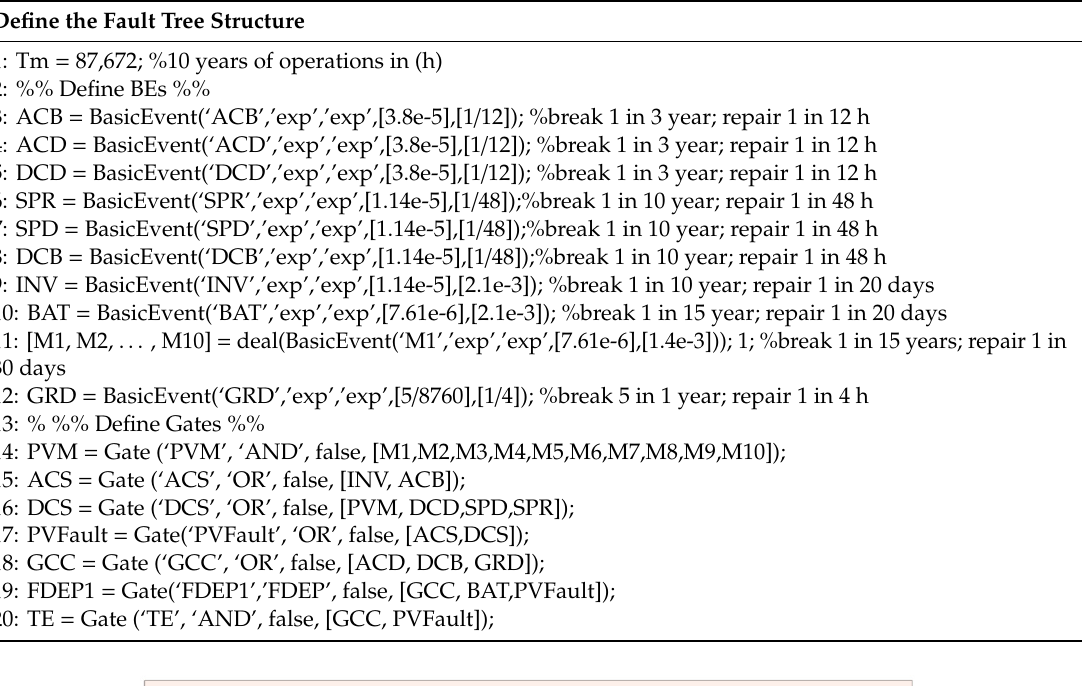
Table 6. DFT model syntax with the SHyFTOO library.